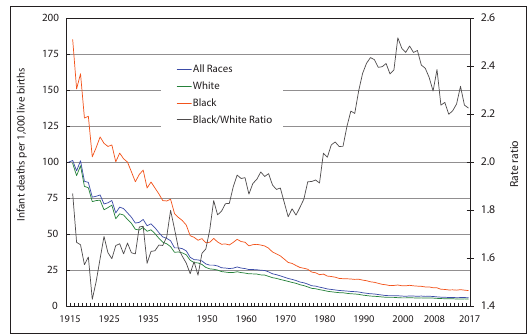
Figure 2 : Infant Mortality Rate by Race, United States, 1915-2017 Source: US National Vital Statistics